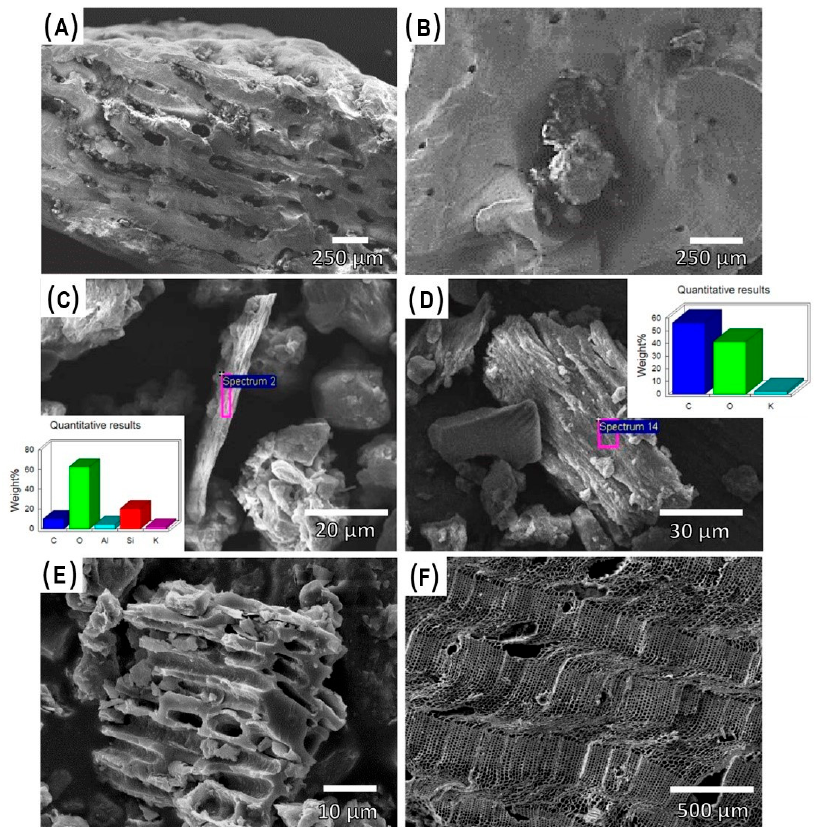
Figure 4. Anthracomass composition—charred bones >5 mm in ( A ) Yudinovo-1 CL1 and ( B ) Khotelevo-2, hearth; plant debris <0.5 mm in Khotelevo-2, hearth—( C ) plant debris consisting of biogenic silica (phytoliths) and ( D ) plant debris that do not form phytoliths; charred wood particles in ( E ) Khotylevo-2 CL, house fill, and ( F ) Yaroslavl CL3.